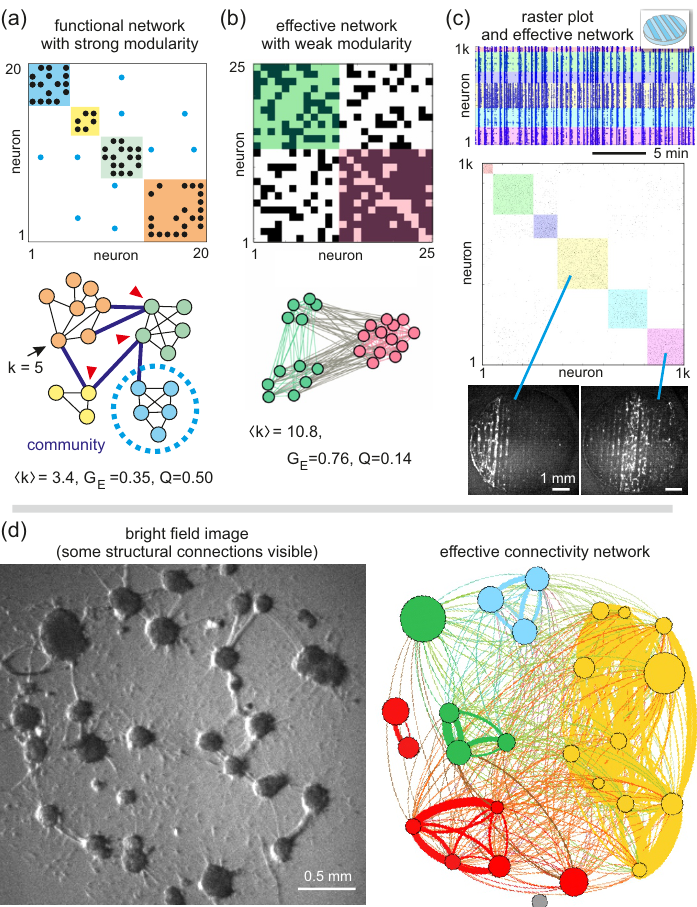
Figure 6. Complex networks and neuronal cultures. ( a ) schematic representation of important concepts in complex networks. Top: adjacency connectivity matrix of a sparse functional network (symmetric matrix) with 20 nodes (ascribed as neurons) and four communities, with the matrix ordered to highlight communities (color boxes). Black dots are intra-community connections and blue ones are inter-community connections. Bottom: representation of the matrix as a network map. Circles are neurons colored according to the community they belong to, and lines are connections (black or blue for intra- or inter-community connections). Red arrowheads indicate hub nodes. The quantities k , (cid:104) k (cid:105) , G E , and Q indicate different network measures; ( b ) example of a dense effective network (asymmetric matrix) with two strongly bonded communities; ( c ) typical effective connectivity analysis pipeline in data from a ‘tracks’ topographical culture. Spike trains of neuronal pairs in a raster plot (with 1000 neurons) are analyzed to extract the effective connectivity network, which effectually captures the dynamic interaction between neurons. Both the effective network and the raster plot are ordered to highlight communities (color bands or boxes). Communities reflect distinct spatiotemporal patterns of activity; ( d ) comparison between structural and effective connectivity. Left, bright field image of an aggregated culture in which major paths of structural connections (straight filaments) are visible. Right, map of effective connections extracted from spontaneous activity recordings on the same network. Colors highlight the network organization in communities. Discs represent the aggregates, with their diameter proportional to the size of the aggregates in the bright field image. Curves are effective connections, with their width proportional to the connectivity strength. The directionality of connections is omitted for clarity. Data in ( c ) and ( d ) were obtained by using GCaMP6s and Fluo-4 as calcium indicators,